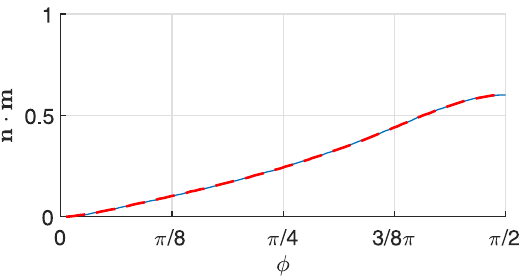
Figure 12. Dependence of n · m on φ for uniaxial loc on φ for uniaxial compression the element size according to (7) or (22) affects only the post-localization stage of response. List of